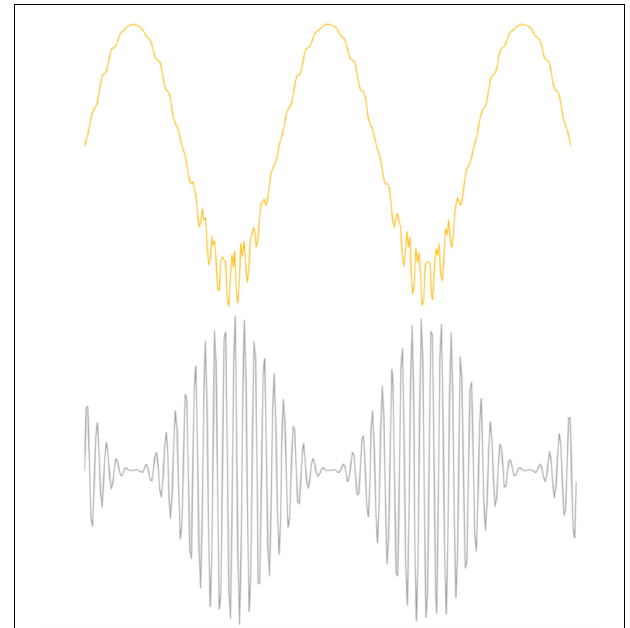
FIGURE 3 | Example of Phase Amplitude coupling, one form of cross frequency coupling (CFC). The top figure illustrates the effect of coupling on beta oscillations where the bottom figure represents gamma oscillations. Beta modulates the amplitude of gamma and gamma perturbs the envelope of beta. CFC is essential for normal brain function, but over or under coupling can be pathological.